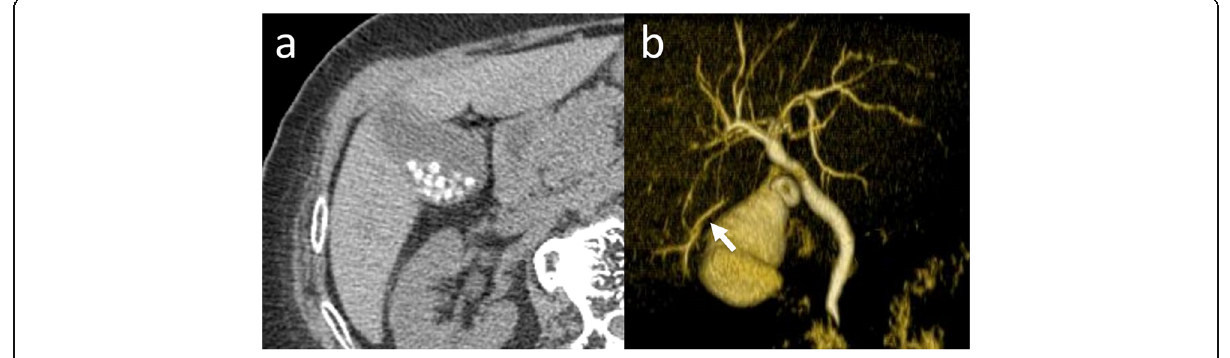
Fig. 1 a Computed tomography scan revealing multiple calcified stones in the gallbladder. b Preoperative drip infusion cholecystocholangiography-computed tomography showing a bile duct branch with no communication between the intra- and extrabiliary systems